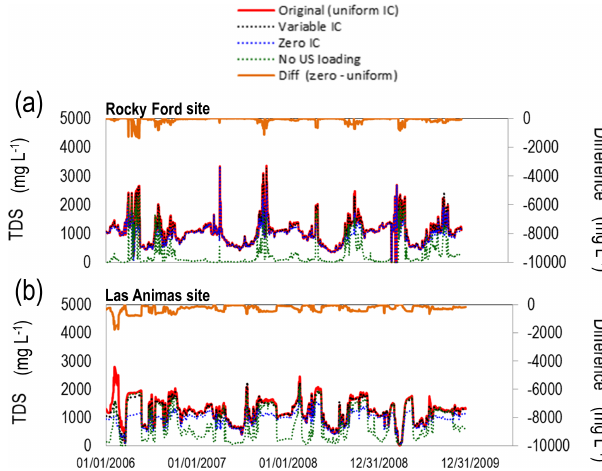
Figure 14. Simulated in-stream TDS concentration (mgL − 1 ) at the Rocky Ford and Las Animas gage sites along the Arkansas River for four scenarios: uniform initial conditions (IC) of salt soil water and groundwater concentrations, corresponding to the original sim- ulation; variable IC; IC = 0; and no upstream loading of salt at the Catlin Dam site. Also shown is the difference between the IC = 0 scenario and the original scenario.